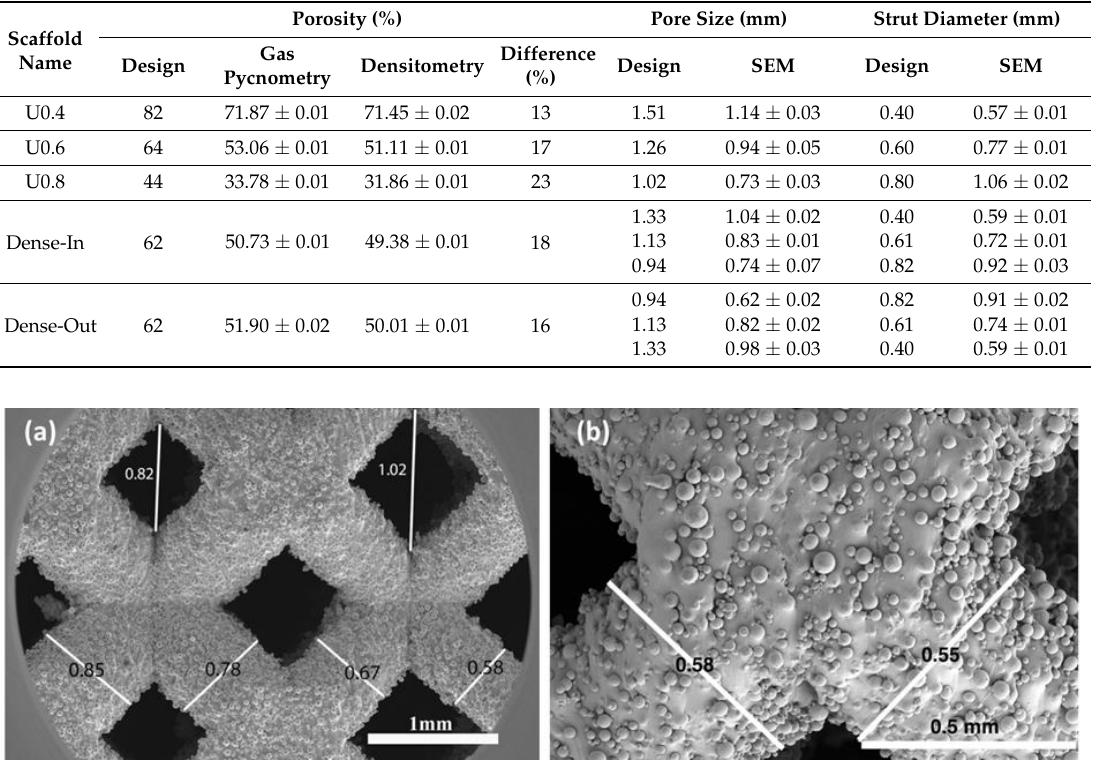
Figure 2. SEM image of ( a ) a gradient Dense-Out structure, demonstrating the change in strut diameter and pore size along the scaffold, ( b ) higher magnification view of the struts showing attached semi-molten powders.